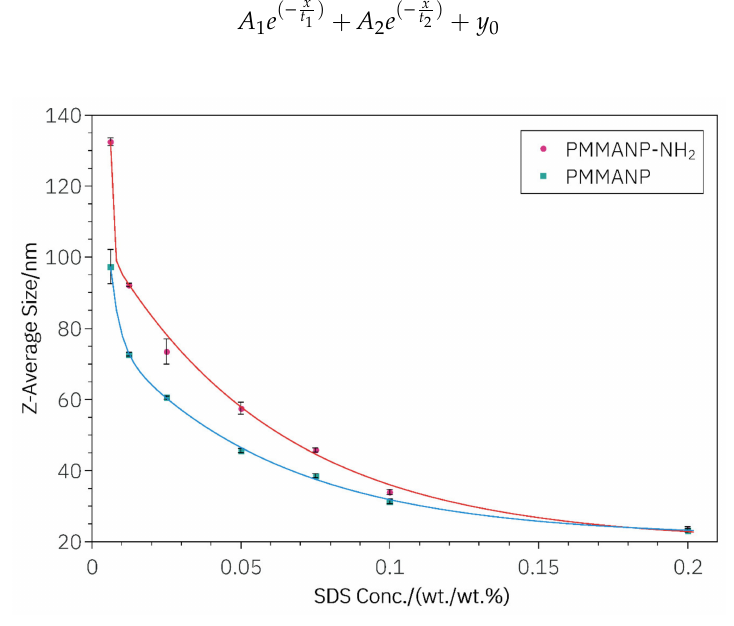
Figure 2. Size tunability of PMMANPs and H 2